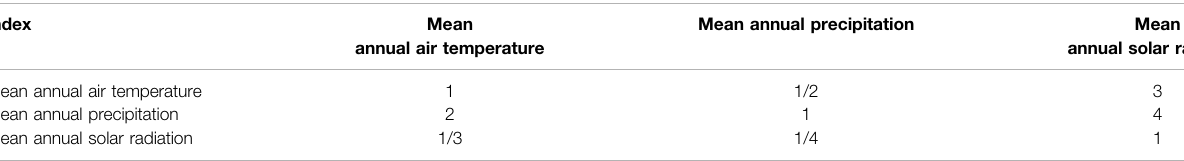
TABLE 10 | Judgment matrix of climatic environment.